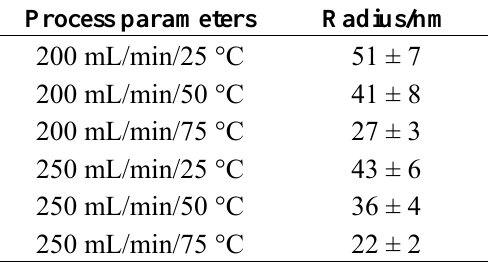
Table 2. Particle size determined using dynamic light